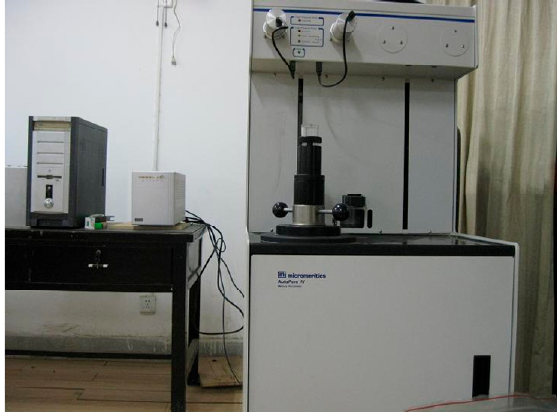
Figure 1. MK-AutoPore IV9510 mercury injection apparatus.